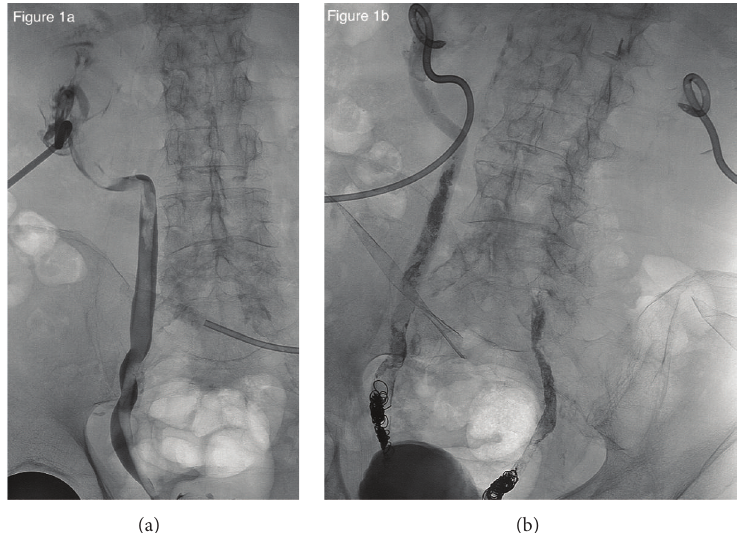
Figure 1: (a) Nephroureterogram through the indwelling left nephrostomy catheter shows moderate dilation of the left ureter with multiple large, irregular filling defects throughout the collecting system and ureter representing the thrombus burden. The contracted urinary bladder containing a large thrombus burden is also shown. (b) Postembolization fluoroscopic image showing occlusion of both distal ureters with a combination of coils and